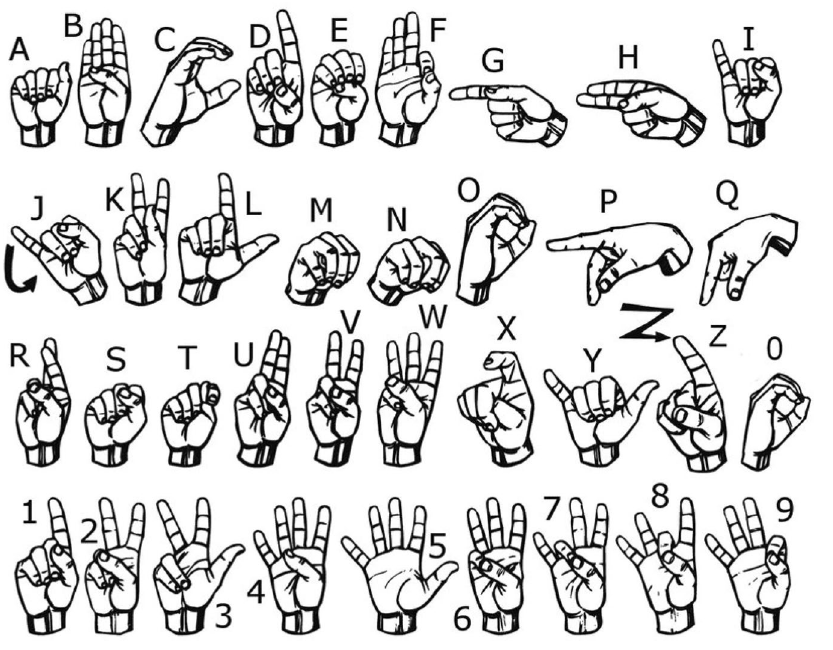
Figure 7. The standard ASL signs for letters and numbers 69 .